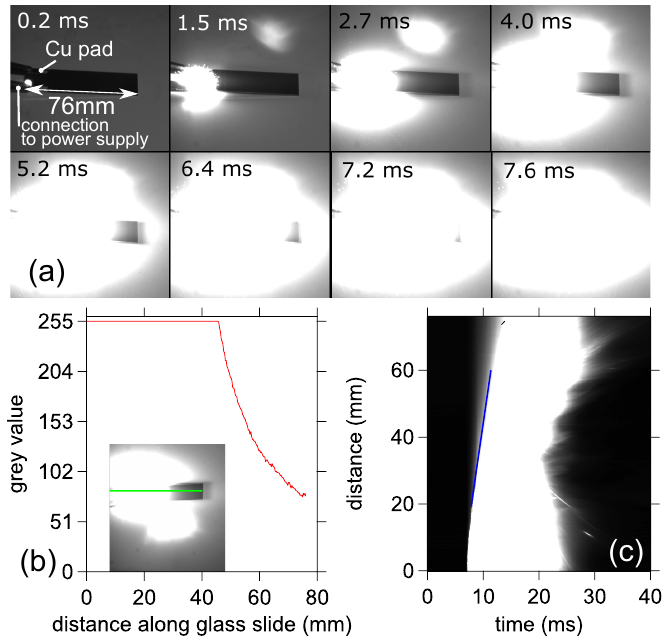
Figure 2. ( a ) Snapshots taken during multilayer reaction front velocity measurement using the ultra-high speed camera FASTCAM SA4. The dark region is the non-reacted part of the sample. ( b ) Measured line profile. The inset shows the image, together with the profile line (green). ( c ) Com- pilation of line profiles to determine the front velocity. The blue line indicates the boundary between the dark and white region used to determine the velocity. The slope of the blue line corresponds to the average velocity